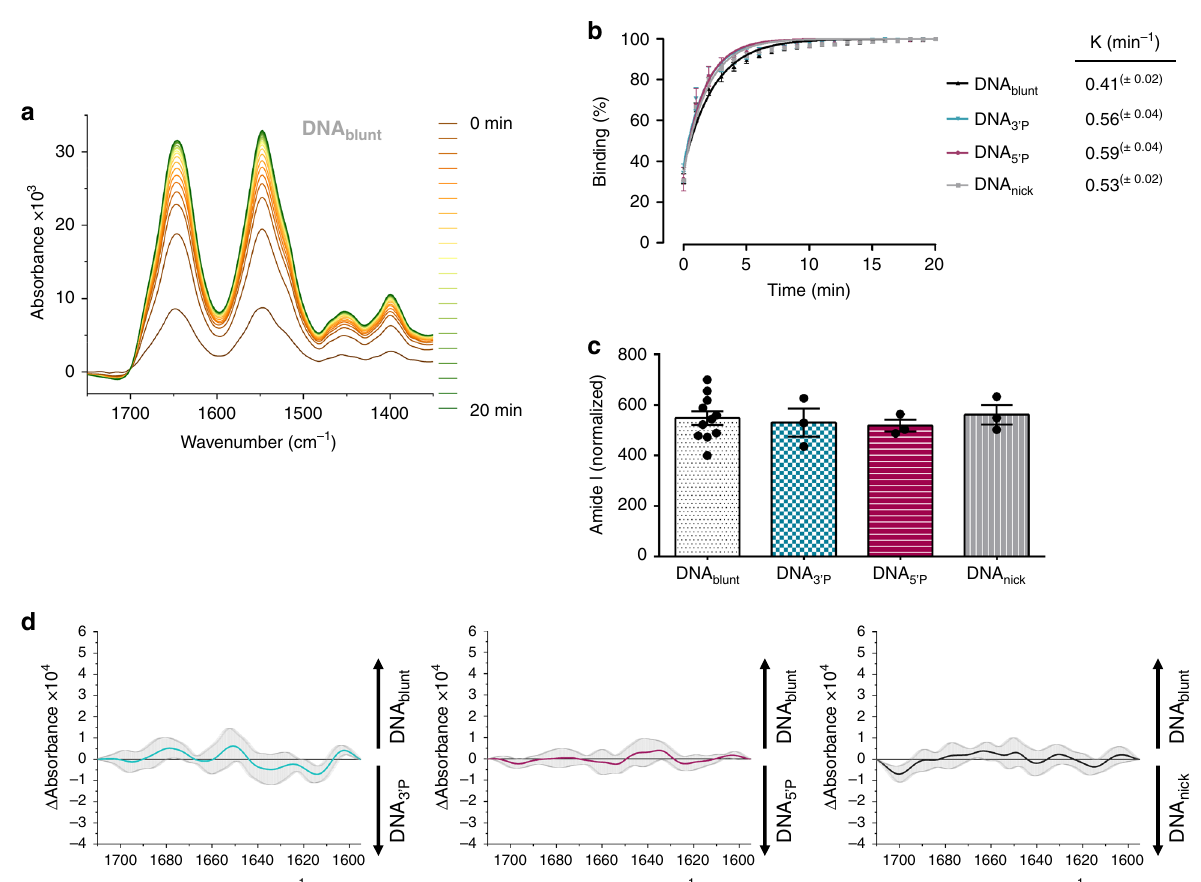
Fig. 2 Binding of PARP1 to DNA strand break-mimicking oligonucleotides. a Representative time-dependent spectra of PARP1 binding to immobilised DNA blunt . b Evaluation of time-dependent binding of PARP1 to different types of DNA strand breaks. ‘ 0 min ’ refers to the fi rst time point measured. Signal intensities of amide I bands (1645 cm − 1 ) at 20 min were set to 100%. Binding kinetics were calculated via a mono-exponential fi t function. c Comparison of the amount of PARP1 bound to different types of DNA stand breaks after 20 min of co-incubation. Amide I bands (1645 cm − 1 ) were normalised to the amount of immobilised DNA (1220 cm − 1 ). b , c Data from same experiments. Means ± SEM of n = 14 (DNA blunt ) and n = 3 (DNA 3 ’ P , DNA 5 ’ P , DNA nick ) independent experiments, respectively. d Secondary structure analysis. Difference spectra of amide I bands of PARP1 bound to DNA blunt and DNA 3 ’ P , DNA 5 ’ P or DNA nick were calculated. Average curves and SD (grey) of nine difference spectra are plotted ( n = 3 independent experiments, respectively). Source data are provided as a Source Data fi